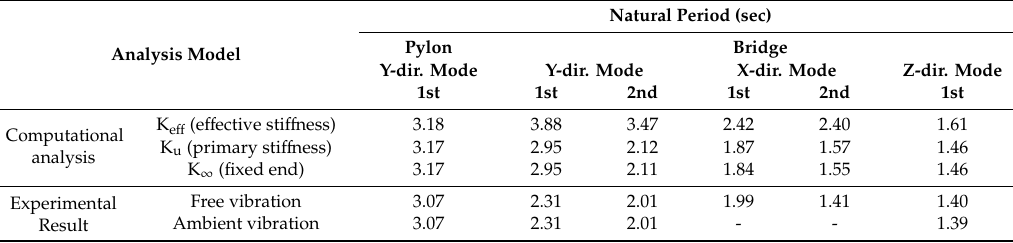
Table 6. Comparison of natural periods of computational and experimental